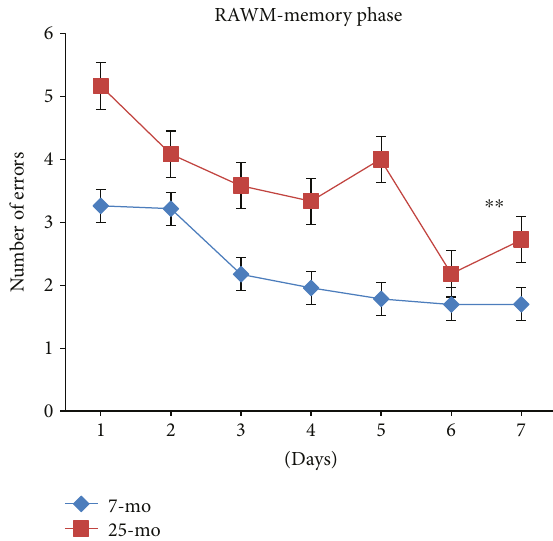
Figure 8: Number of errors of 7- and 25-month-old C57BL/6 mice in memory phase of RAWM (mean ± SEM). ∗∗ P < 0 01 .